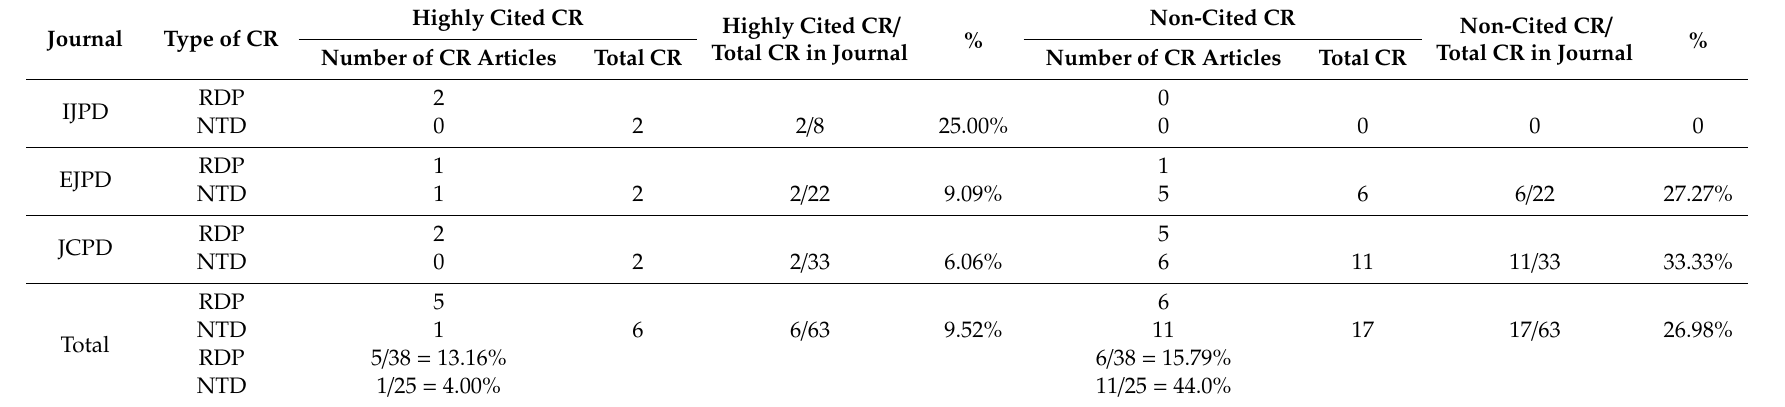
Table 5. Characteristics of highly cited (at least 5 citations) and un-cited CRs in major PD journals.